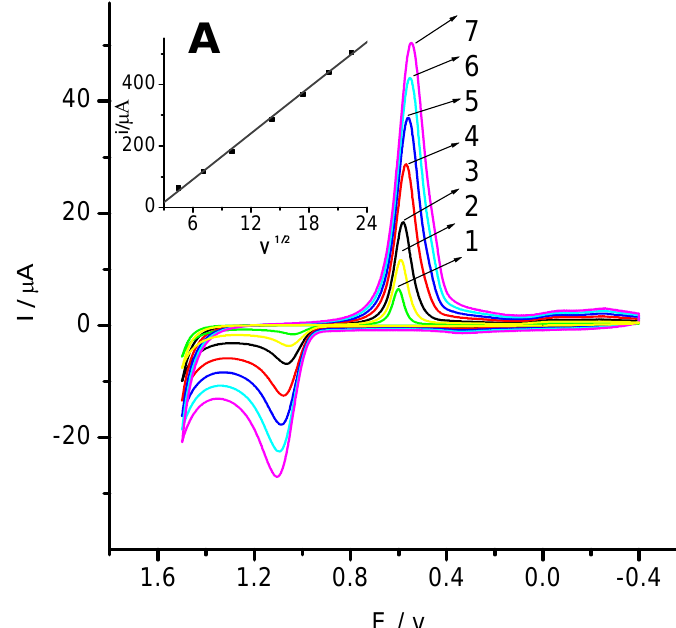
Figure 3. Cyclic voltammograms of gold/complex electrode (solid line) in a 0.5 M buffer solution of HAc-NaAc. 1–7: 20, 50, 100, 200, 300, 400, and 500 mV·s − 1 (from inside to outside). Inset ( A) : the variation of cathodic peak current with scan